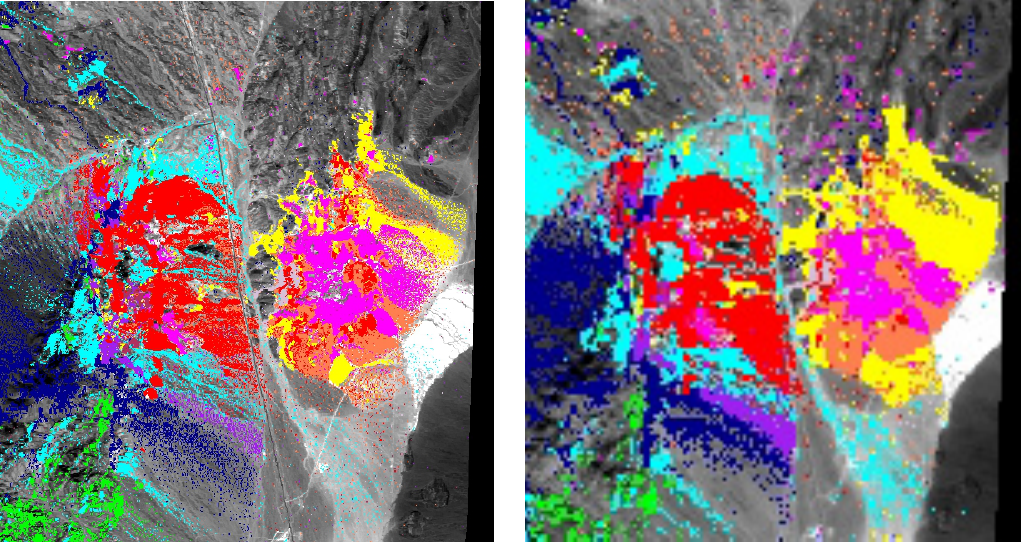
Figure 3. Left: Zoomed portion of the 15 m spatial mineral map over the Cuprite Mining District. Endmember spectra used and colors match Figure 1 (Left). Image base is approximately 10 km, north is to the top. Right: Zoomed portion of the 60 m HyspIRI-simulated mineral map over the Cuprite Mining District. Endmember spectra used and colors match Figure 1 (Left). Image base is approximately 10 km, north is to the